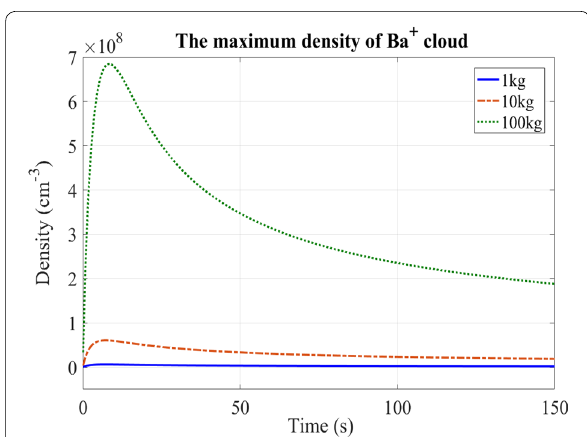
Fig. 5 The density of artificial plasma clouds at the release center varies with time under different release masses. The maximum densities of Ba + clouds are 5.93 6.84 10 6 cm − 3 when 1 kg, 10 kg, and 100 kg of barium are released, ×